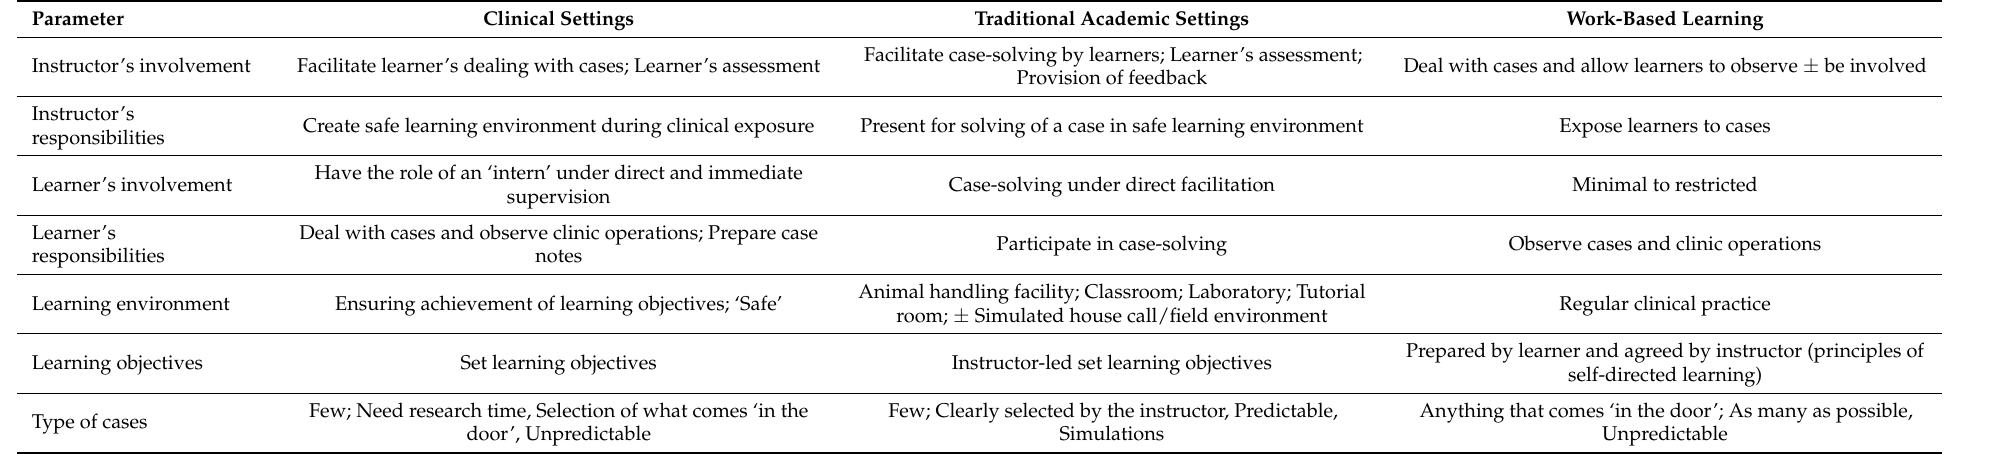
Table 2. Influence of clinical teaching setting on instructor and learner involvement and responsibilities for clinical